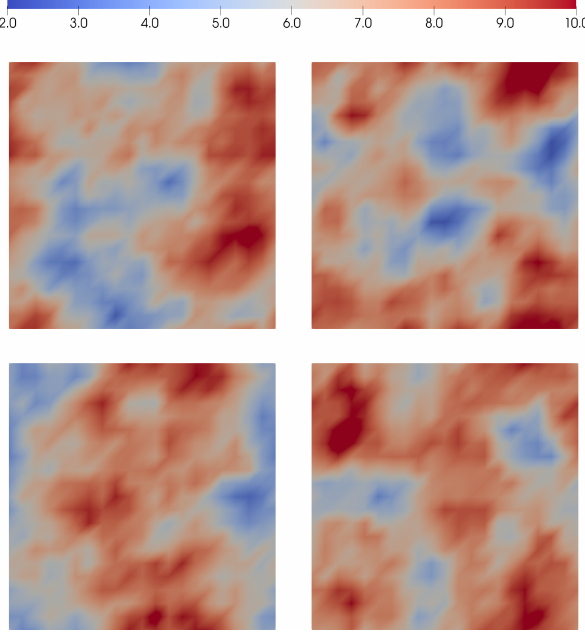
Figure 12. Four samples from the prior for the basal sliding param- eter field for Example